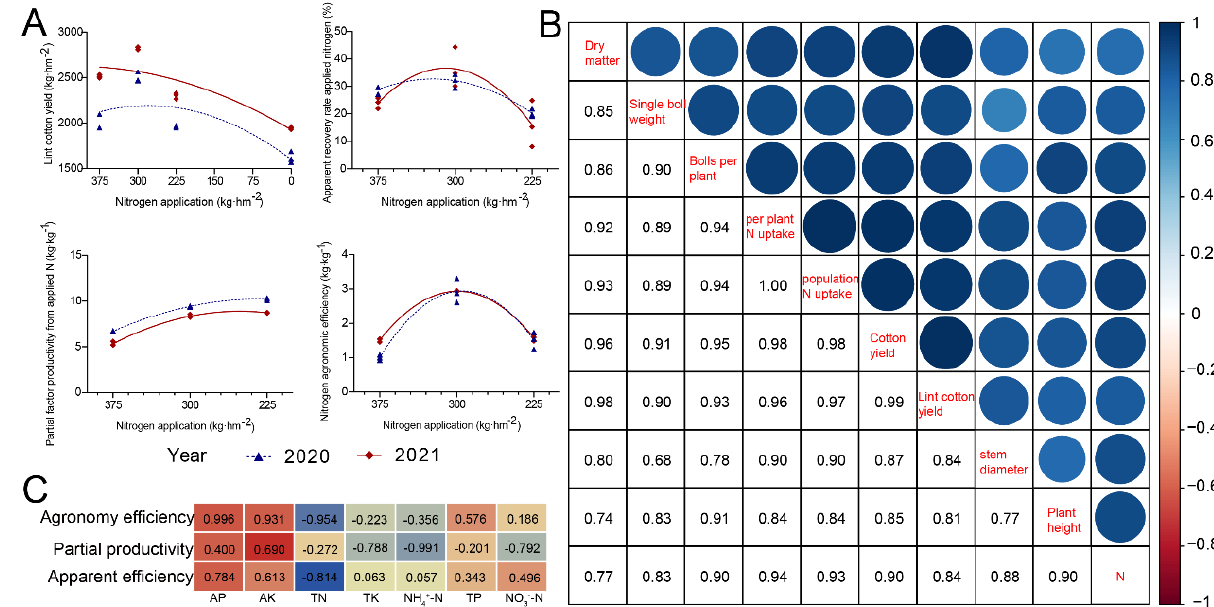
Figure 2. Cotton yield, correlation analysis and nitrogen use efficiency. ( A ) Lint yield and nitrogen use efficiency of different RNE treatments in two years. Blue represents the year 2020. Red represents 2021. Fitting was performed using ordinary least square. ( B ) Correlation analysis of yield components and RNE. Blue represents positive correlation. Red represents negative correlation. The size of the circles represents the level of correlation. Correlations were calculated using Pearson’s coefficient. ( C ) Correlation analysis between nitrogen use efficiency and soil nutrients. Redder colors represent higher correlation. Correlations were calculated using Pearson’s